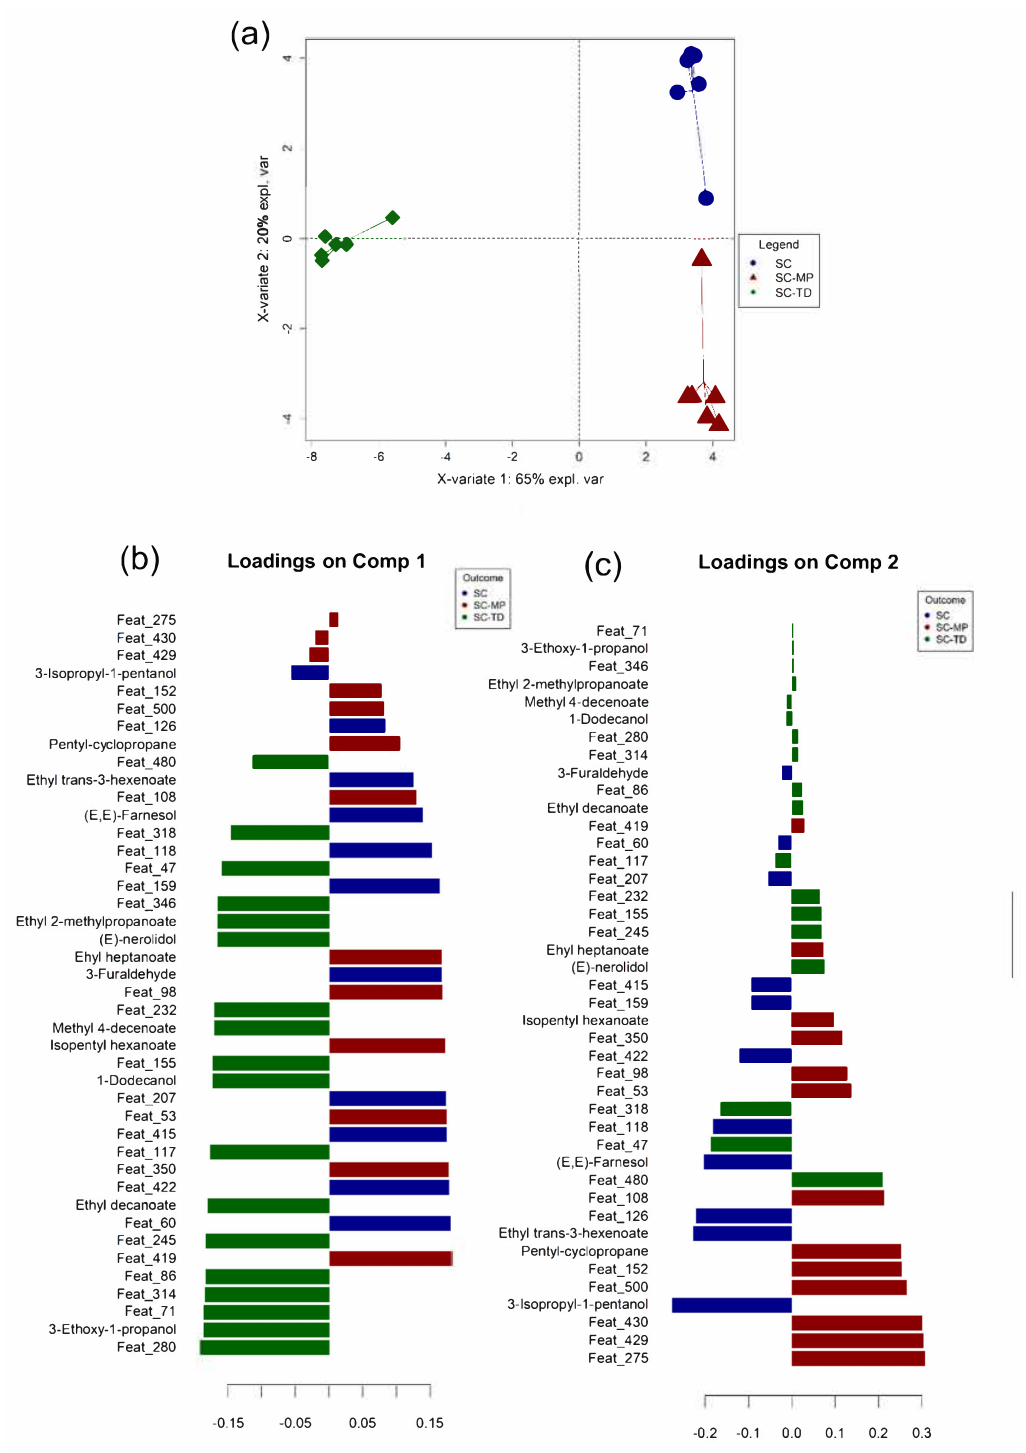
Figure 3. Graphical outputs of the partial least squares discriminant analysis (PLS-DA) performed to classify ros é wines according to the fermentation strategy on the basis of their volatile profile. ( a ) Scores plot for the components 1 and 2; ( b ) and ( c ) loading contribution barplot on components 1 and 2. Colour indicates the class for which the compound has a maximal mean value. Bar length represents the multivariate regression coefficient with either a positive or negative sign for that particular feature of each component, i.e., the importance of each variable in the model. Sc-Td : wines fermented with sequential inoculation of Torulaspora delbrueckii and Saccharomyces cerevisiae . Sc-Mp : wines fermented with sequential inoculation of Metchnikovia pulcherrima and Saccharomyces cerevisiae . Sc : wines fermented with monoculture of Saccharomyces cerevisiae